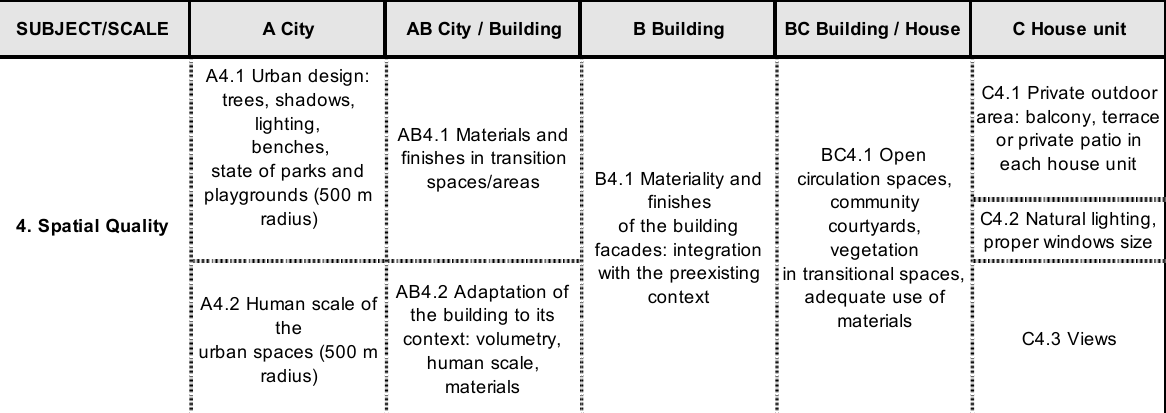
Figure 4. Spatial Quality Indicators. Source own elaboration.